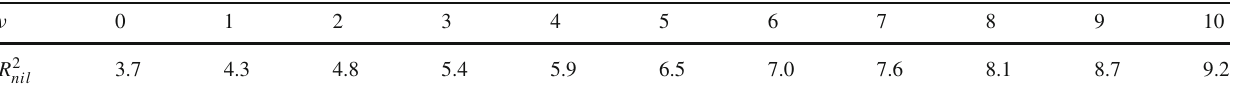
for the 3D nilmanifold N 3 , corresponding to Eq. (2.32) for κ = 2 nil